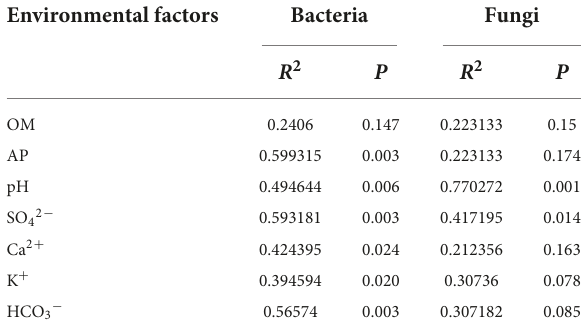
experimental results undoubtedly provide explanatory ideas for the differences in rhizosphere microbial diversity among C. salsa parasitizing different host plants.